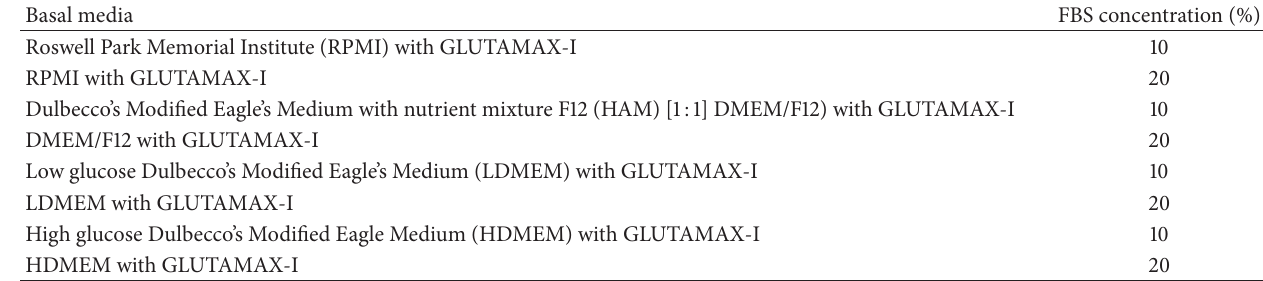
Table 1: Basal media and FBS concentration used for CFU-f